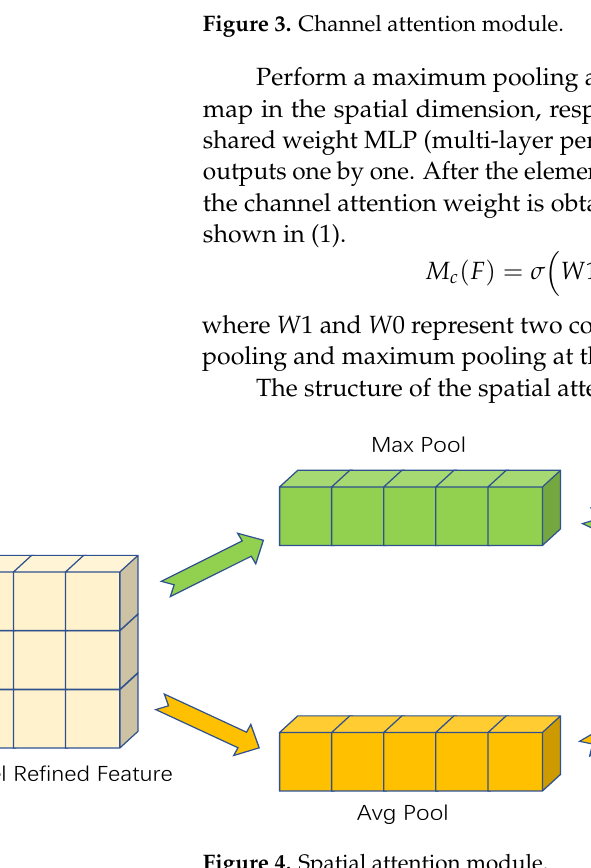
Figure 4. Spatial attention module.